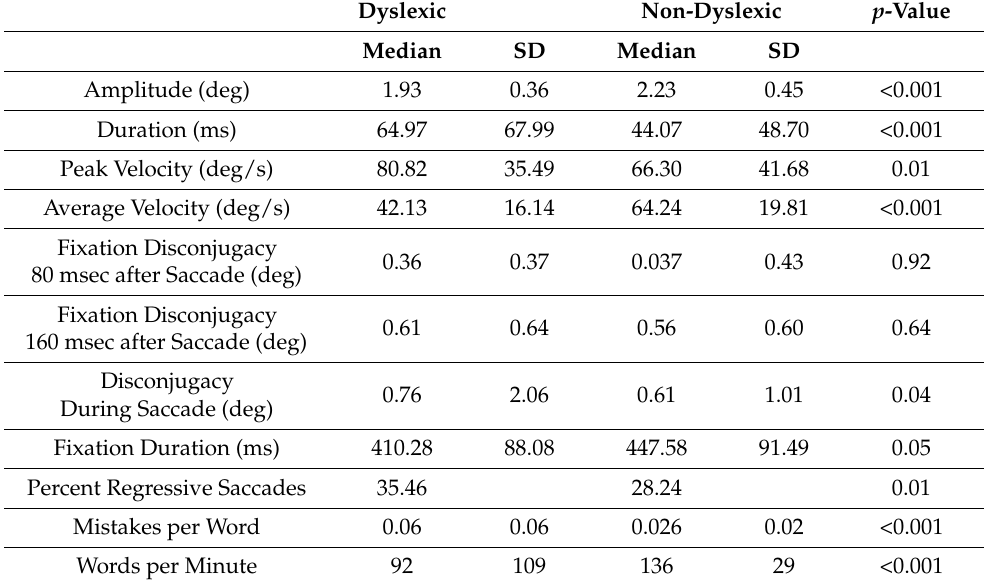
Table 1. Reading L’Alouette